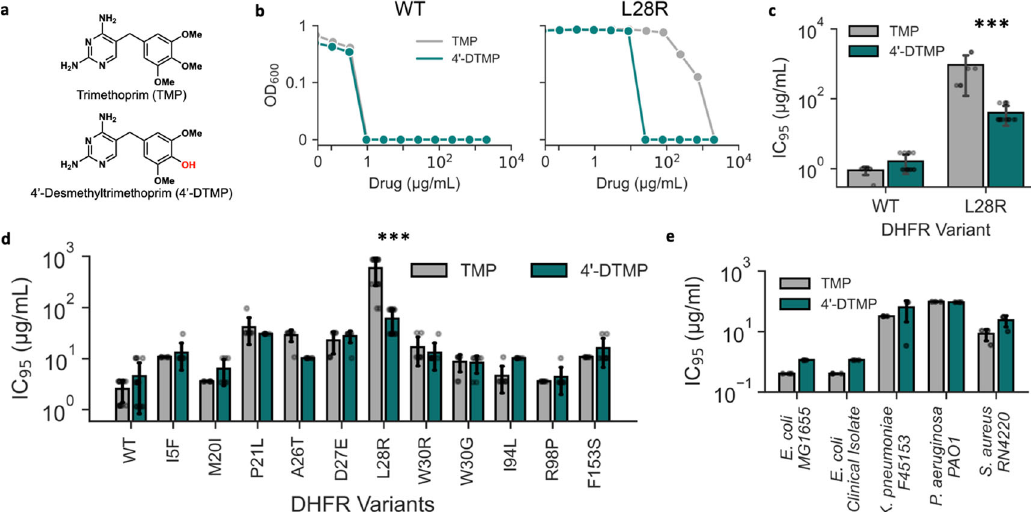
Fig. 2 4 ′ -DTMP has enhanced and selective antimicrobial activity against E. coli with the L28R mutation in DHFR. a Structure of Trimethoprim (TMP) and 4 ′ -desmethyltrimethoprim (4 ′ -DTMP). b Representative drug dose response curves for TMP (gray) and 4 ′ -DTMP (teal) against E. coli harboring wildtype DHFR (wild-type, left) or DHFR with the L28R mutation (right). All DHFR mutant strains were constructed in MG1655 attTn7::pRNA1-tdCherry (NDL47, see Methods ” section) by replacing the chromosomal folA gene with the corresponding chemically synthesized folA variant sandwiched between kanamycin and chloramphenicol resistance genes. c Activity of 4 ′ -DTMP (teal) is indistinguishable from TMP (gray) activity against wildtype E. coli ( n = 7 replicates), whereas 4 ’ -DTMP (teal) has ~30-fold higher antimicrobial activity ( p = 9.597 × 10 − 4 , n = 14 replicates) compared to TMP (gray) against E. coli with L28R- mutation. d Activity of 4 ′ -DTMP (teal) against wild-type and other frequently-observed E. coli mutants with single DHFR mutations is indistinguishable from TMP activity (gray) ( n = 7 replicates), except L28R ( p = 3.5912 × 10 − 6 ). e Indistinguishable antimicrobial activities of TMP (gray) and 4 ′ -DTMP (teal) against other Gram-negative and Gram-positive bacteria as well as a clinical E. coli isolate ( n = 3 replicates). Student ’ s t -test (two tailed) is used to quantify signi fi cance of IC 95 value differences in all panels (* p < 0.05, ** p < 0.01, and *** p < 0.001, error bars show the standard deviation, center of the error bars corresponds to the mean value of the